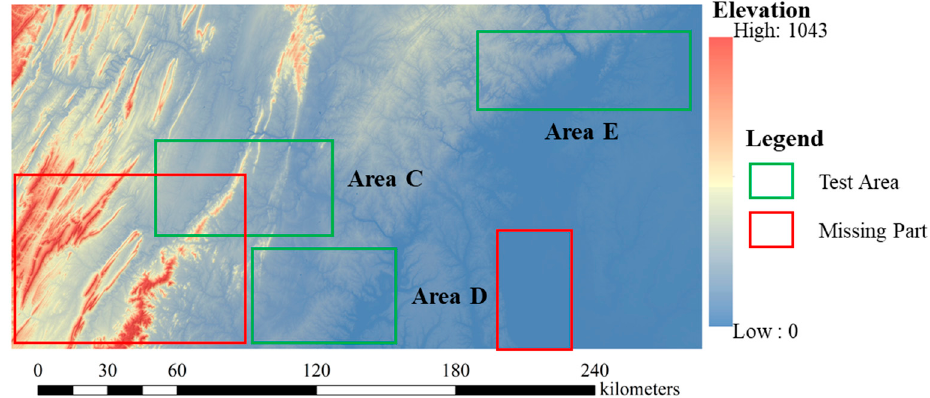
( b ) Figure 10. ( a ) The reconstruction of 10 m DEMs using different methods. ( b ) Zoomed in area B of ( a ). To further verify the practical application of our method, we reconstruct a large-scale area of approximately 44,000 km 2 in Figure 6, which contains a missing part of the high- resolution DEM data, and the results after reconstruction are demonstrated in Figure 11. We chose three testing areas that have almost no missing high-resolution elevation data in the same region to evaluate the performance of the reconstructed results. As Table 2 demonstrates, the low MAE in whichever testing region proves the practical significance of the reconstruction for the missing part of the large-scale data. Table 2. Performance evaluation of our method at the reconstruction scale of 2 on the DEM datasets for the Maryland test area.